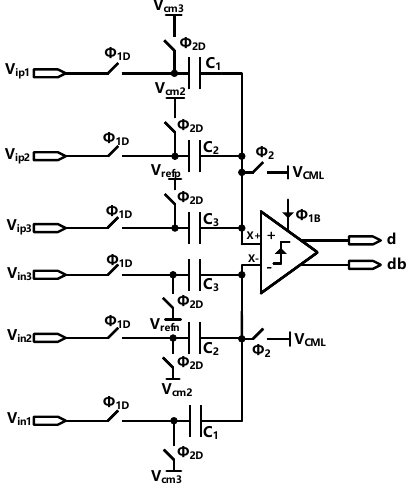
Figure 15. Schematic of the scaling voltage